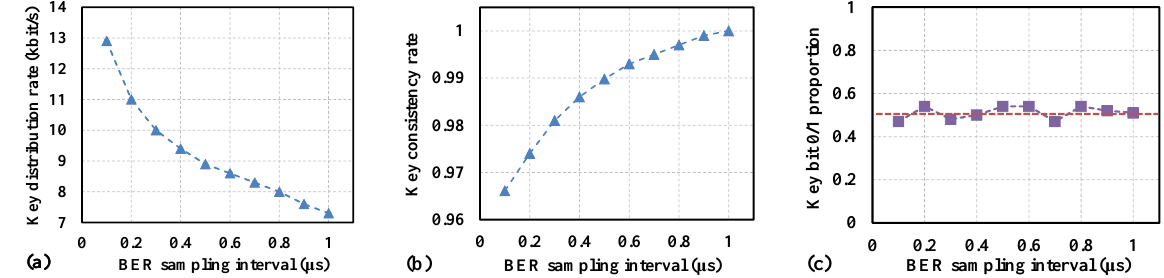
Figure 9. ( a ) Key distribution rate, ( b ) key consistency rate, and ( c ) key bit 0/1 proportion as a function of BER sampling interval.